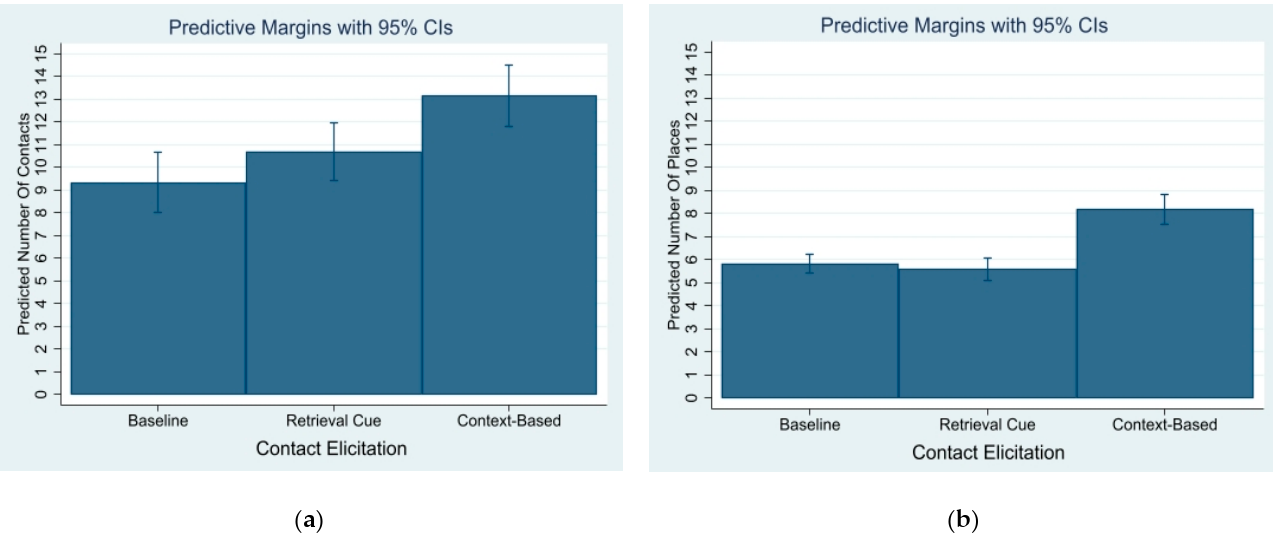
Figure 1. ( a ) Plots of post-estimation mean differences for contacts. ( b ) Plots of post-estimation mean differences for places. Finally, although the addition of the control variables did not impact any of the effects of the experimental manipulations, some of the results were worth noting. Demographi- cally, participants who identified as women were likely to report more contacts ( Est. = 0.16, SE = 0.07, p = 0.03), as well as those who identified as White when compared to those identified as Asian, African American, and Hawaiian/Pacific Islander. Psychologically, those in better moods reported more contacts ( Est. = 0.12, SE = 0.06, p = 0.04), and those who were less worried about COVID-19 reported fewer contacts ( Est. = − 0.08, SE = 0.08, p = 0.04) and places ( Est. = − 0.04, SE = 0.02, p =